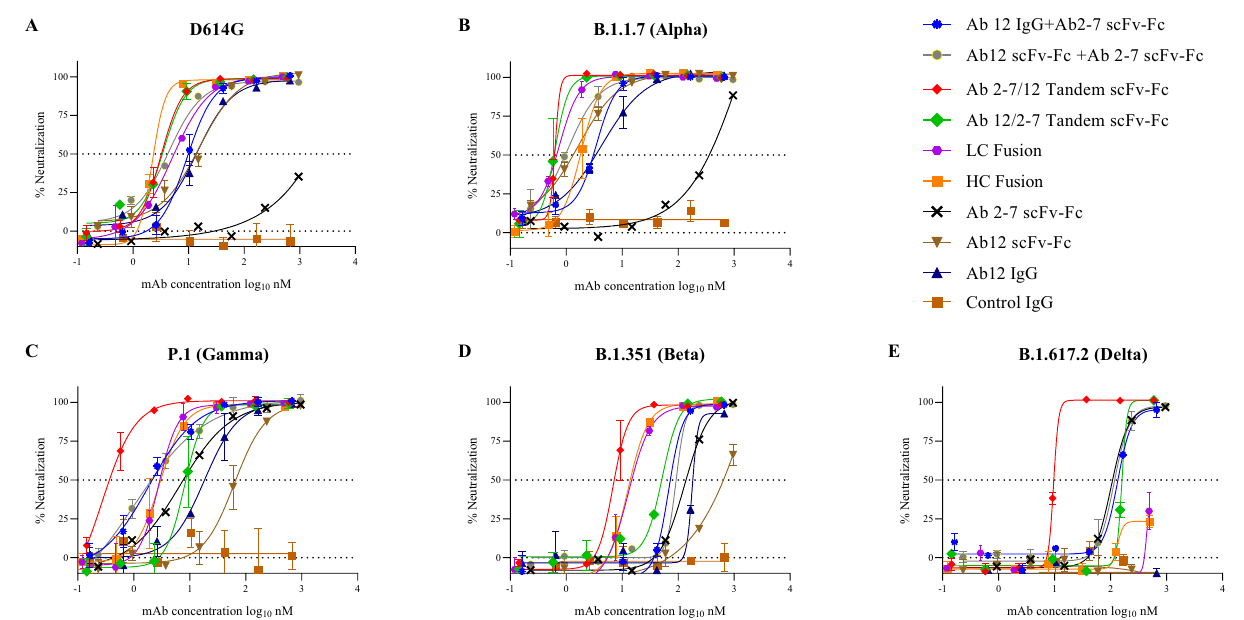
Fig.7|InvitroneutralizationcurvesusingGFPengineeredSARS-CoV-2variant strains. Neutralization curves were performed in triplicate using the mono- and bispeci fi cAbconstructsagainsttheD614Gvariant( A )andthesubsequentB.1.1.7( B ), P.1 ( C ), B.1.351 ( D ), and B.1.617.2 ( E ) variants of concern which contain a number of additionalspikemutations.Thegreatesteffectofthesemutationscanbeseeninthe